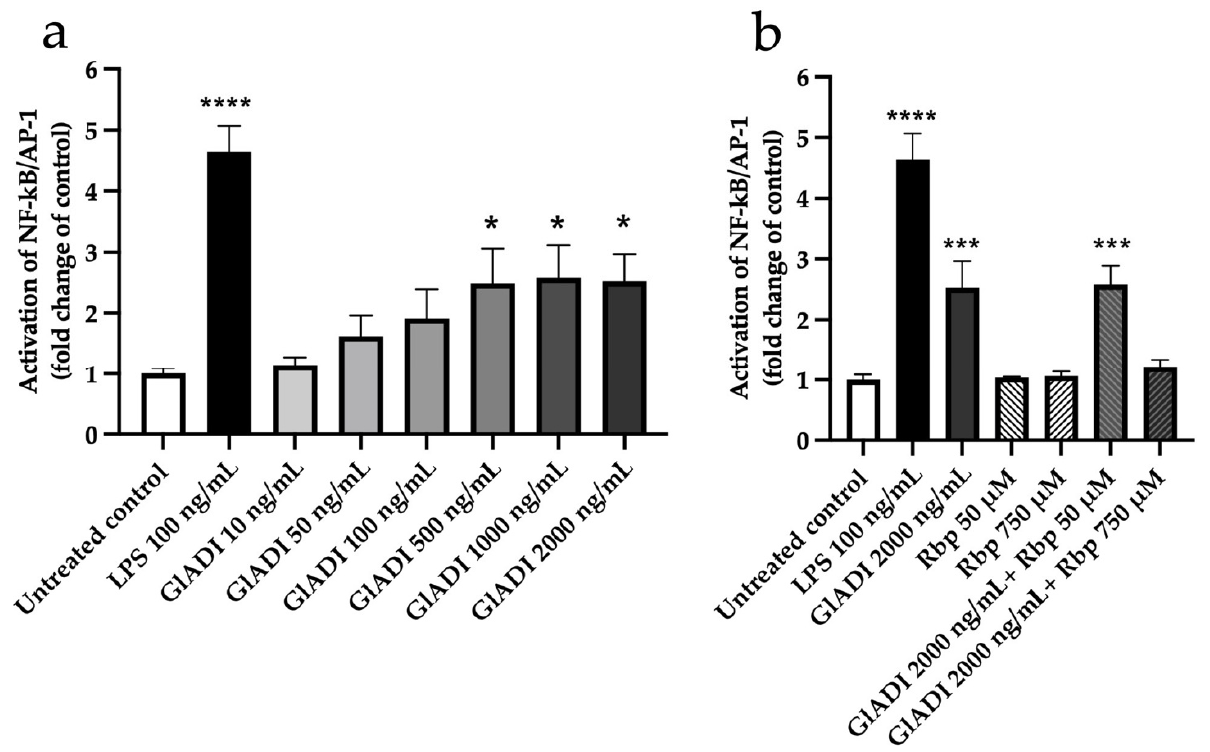
Figure 1. NF- κ B/AP-1 activation in THP1-MD2-CD14 reporter cells. ( a ) Cells were stimulated with rising concentrations of GlADI and ( b ) with rabeprazole (Rbp) or the highest concentration of GlADI mixed with Rbp. Activation of NF- κ B/AP-1 is presented as the untreated control fold change. Results represent the median with the interquartile range of at least three independent experiments, with three technical replicates. Statistical significance levels compared to the untreated control were determined by the Friedman test (non-parametric statistical test), followed by the Dunn’s multiple comparisons test (post hoc test). A p -value < 0.05 was considered as statistically significant (* p < 0.05, *** p < 0.001, **** p < 0.0001).